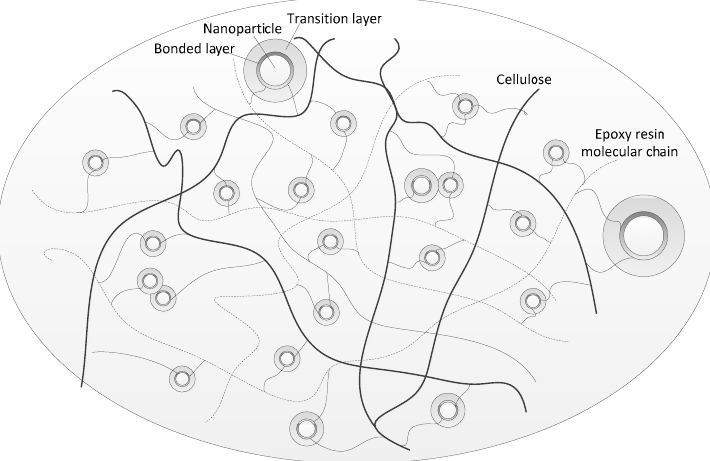
Figure 13. Distribution model of nanoparticles in RIP.